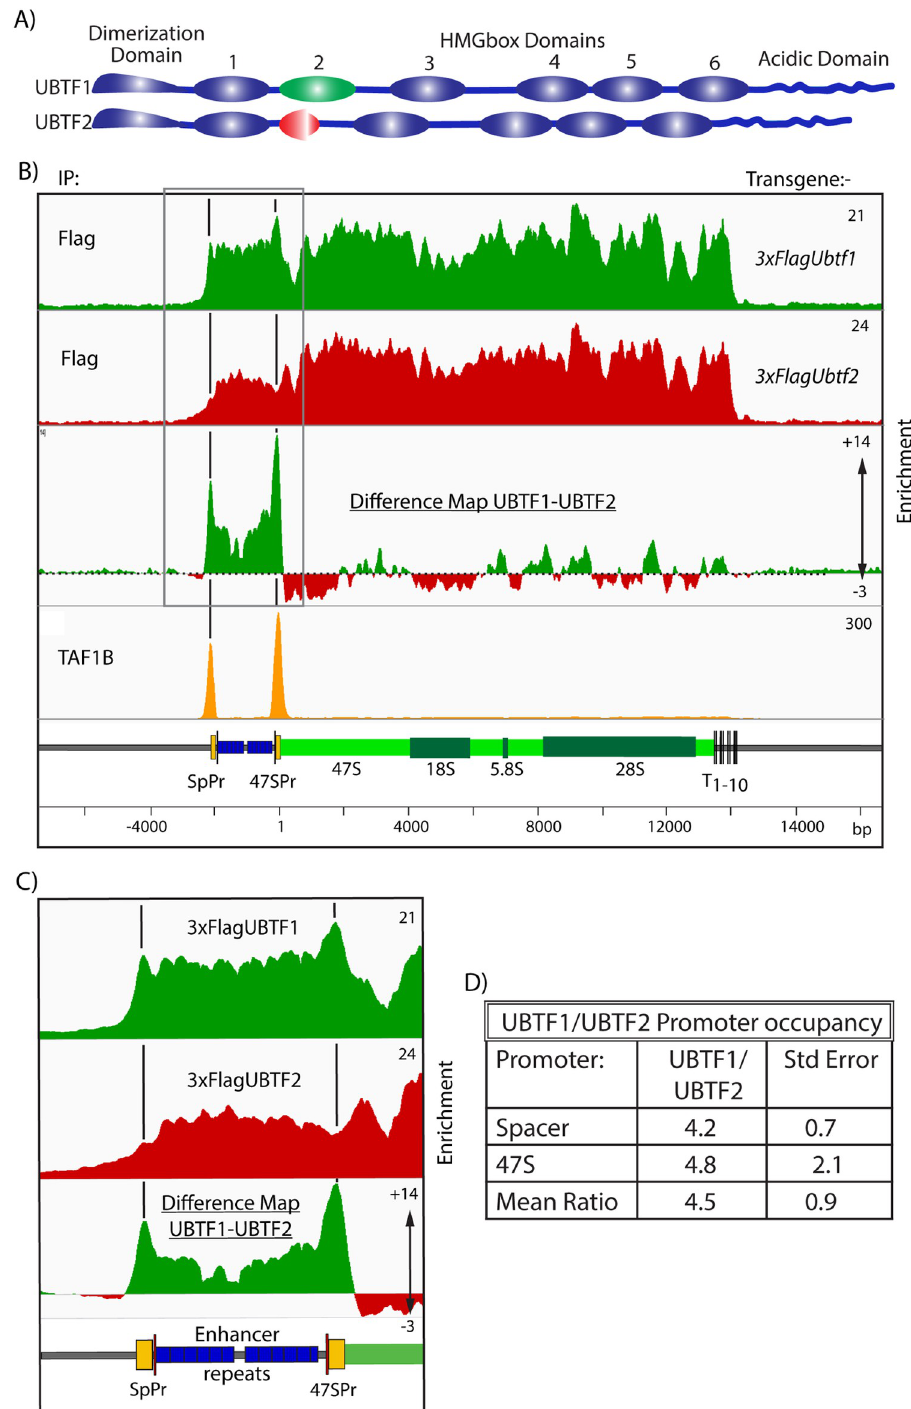
Fig 4. The rDNA promoters selectively recruit the UBTF1 variant. A) Schematic representation of the domain structure of the UBTF splice variants in mouse and human indicating the N-terminal dimerization, 6 HMGbox domains and the C-terminal Acidic Domain. B) DChIP-Seq mapping profiles of exogenously expressed 3xFLAG-UBTF1 or UBTF2, and endogenous TAF1B in NIH3T3 MEFs, see also S9 Fig. The difference map of UBTF1-UBTF2 occupancies reveals a strong selectivity for UBTF1 mapping precisely over the Spacer and 47S promoters. C) Magnified view of the DChIP mapping in B showing detail over the promoter and enhancer regions.